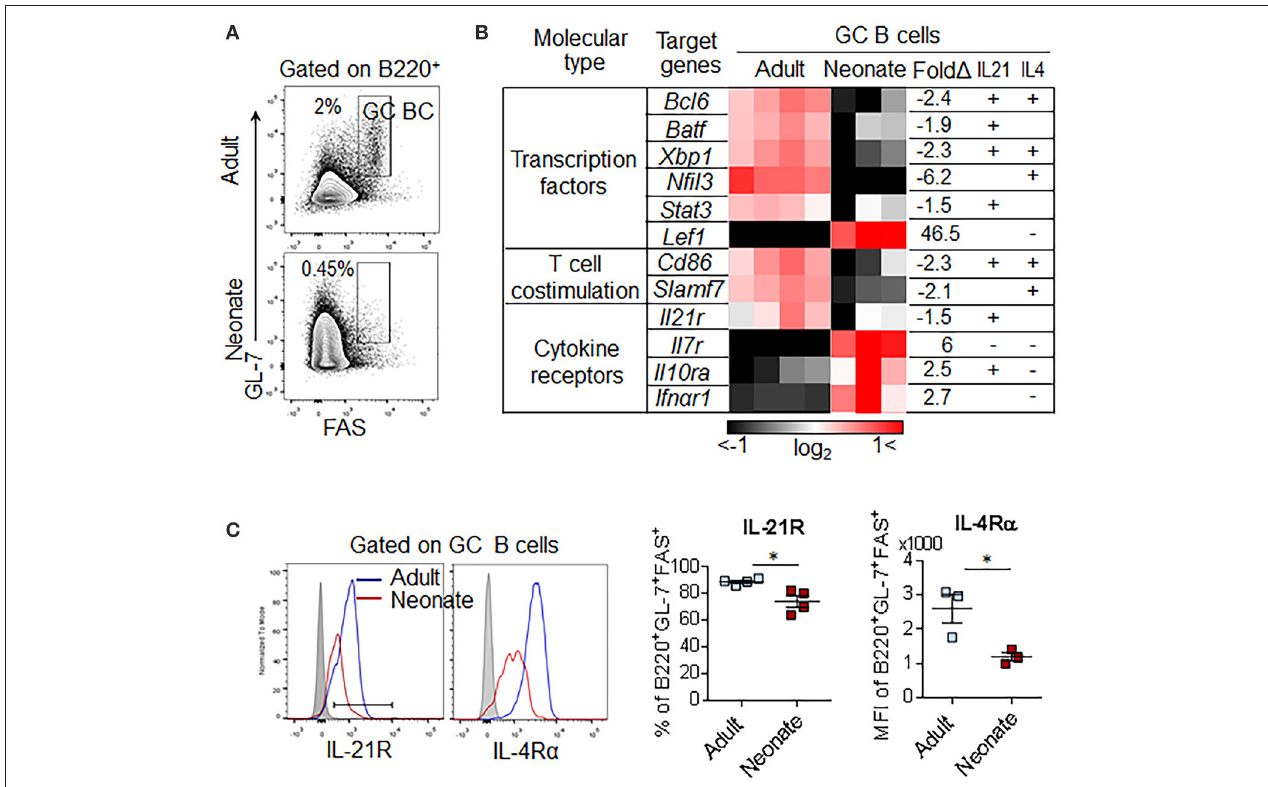
FIGURE 6 | GC B cell pathway analysis and receptor expression. Adult (6 to 10-week-old) and neonatal (5 day-old) mice were immunized i.p. with SRBC. (A) Representative gating of GC B (B220 + GL-7 + FAS + ) 10 dpi for transcriptional analysis. Plots were pre-gated on B220 + B cells. (B) Comparison of GC B cell genes found in ingenuity pathway upstream analysis among genes differentially expressed in neonatal vs. adult GC B cells ( p < 0.05, > 1.5-fold). Selected genes were predicted as downstream genes induced by IL-21 and IL-4. Each column represents one replicate pooled from three adult mice or eight neonatal mice. Upregulated genes, induced by either IL-21 or IL-4 were marked ( + ) and downregulated genes were marked (-). (C) Flow cytometry of splenocytes from immunized mice at 7dpi. Plots were pre-gated on B220 + GL-7 + FAS + GC B cells ( n = 3–4). Error bar, s.e.m.. * p <